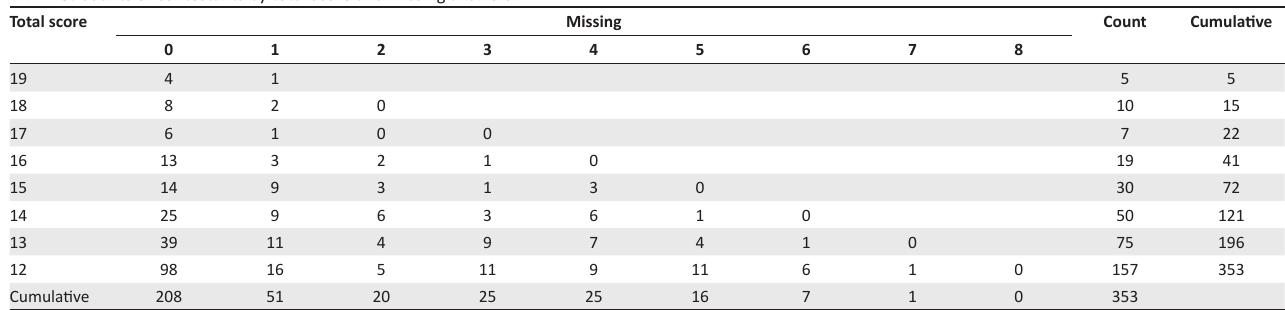
TABLE 3: Counts of contestants by total score and missing answers. Total score